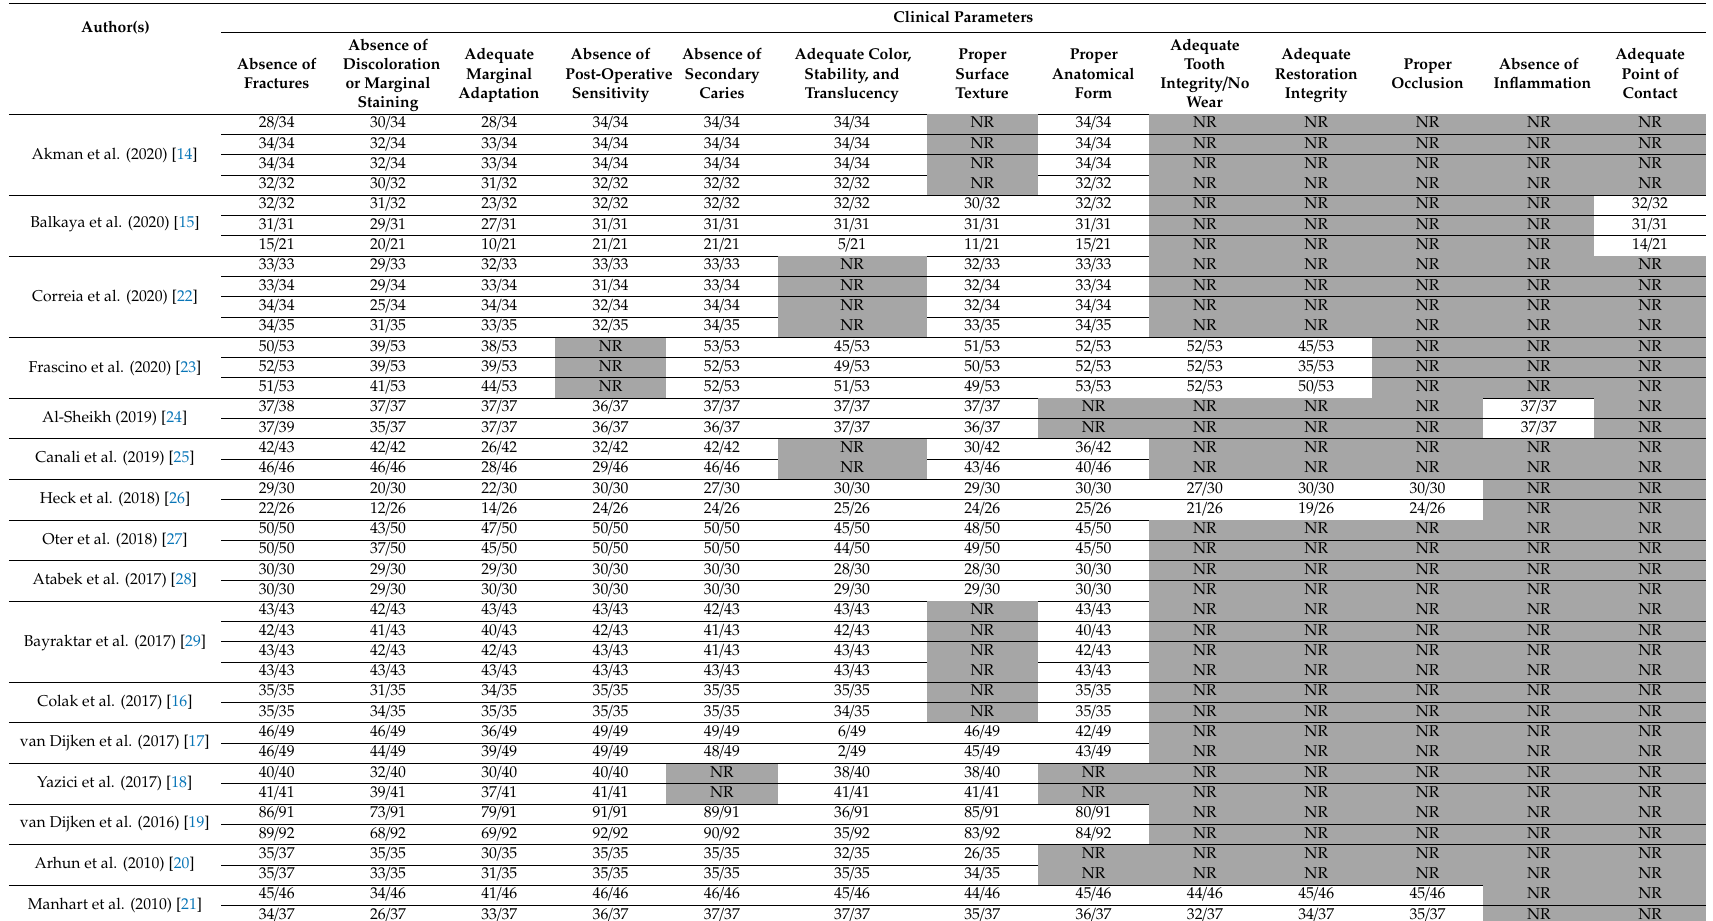
Table 3. Data extracted from included